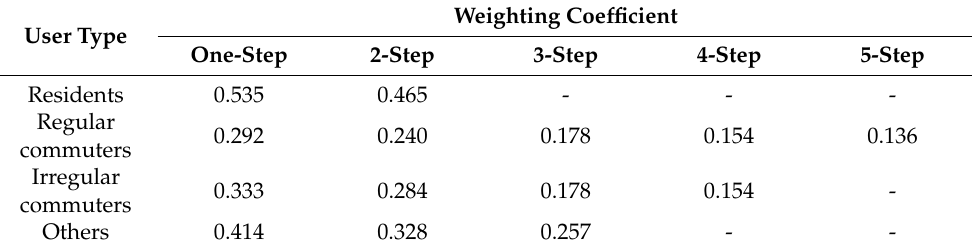
Table 7. Weighting coefficients of different steps for different types of